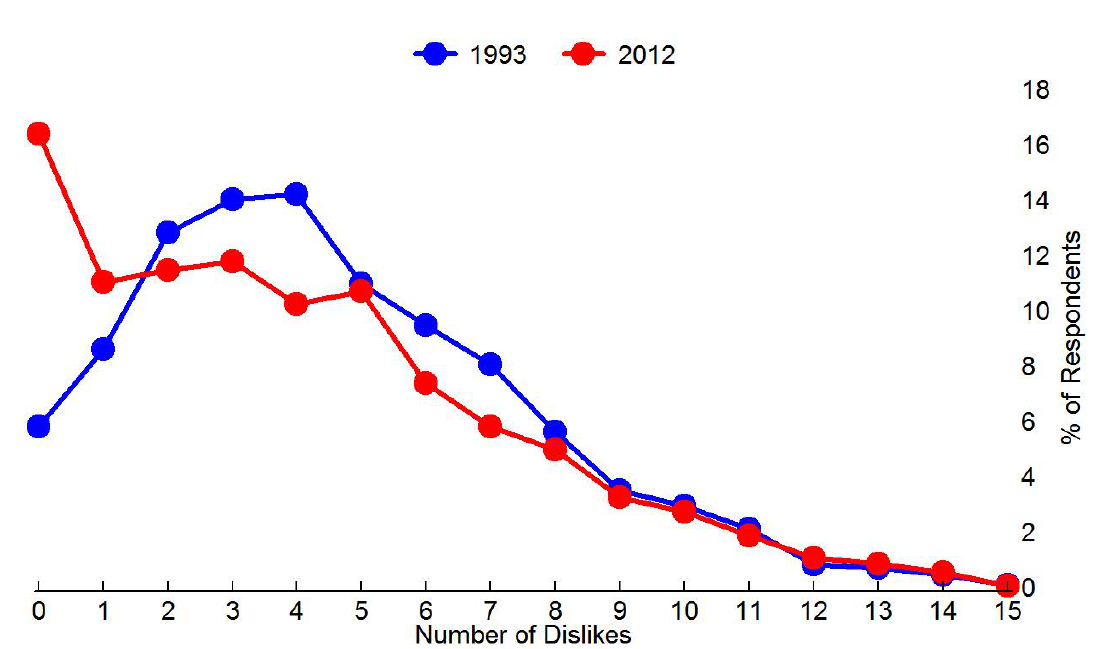
Figure 1: Univariate distribution of counts of the number of dislikes for GSS 1993 (blue) and SSI 2012